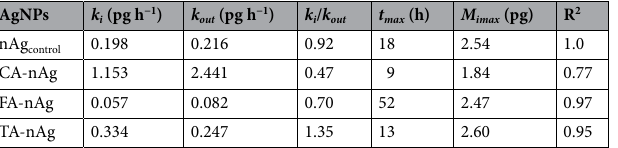
Table 3. Fitting parameters for nAg control , CA-nAg, FA-nAg and TA-nAg internalized into A549 cell with internalizing model (incubated AgNPs concentration was 10 μg ml −1 ).